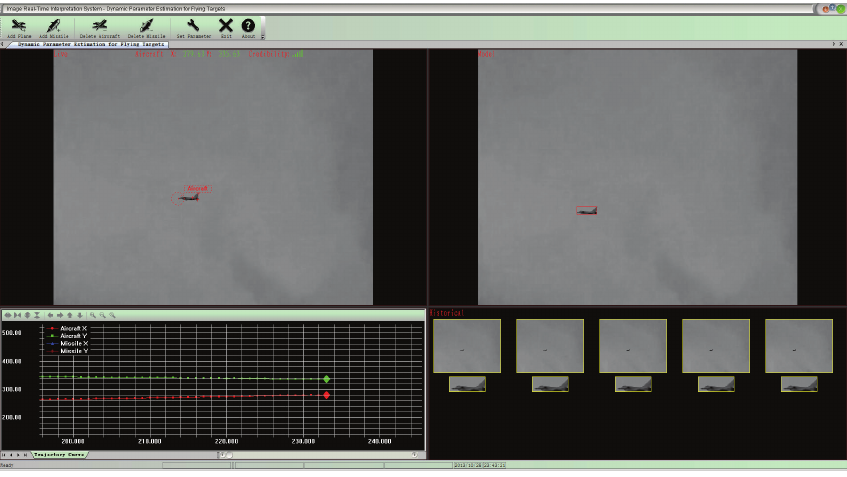
Figure 10: Image interpretation subsystem UI.